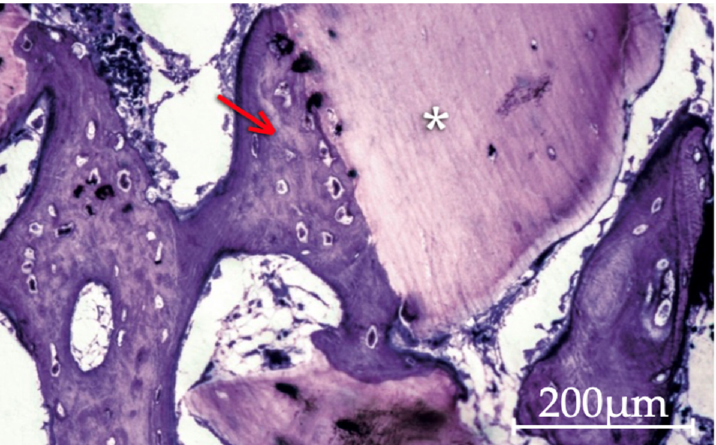
Figure 2. Apatos particles (asterisk) coated by a very immature bone tissue (arrow) formed by direct apposition to the biomaterial surface at 15 days. Areas of lax connective tissue occupying much of the interparticle spaces are still visible (200 × original